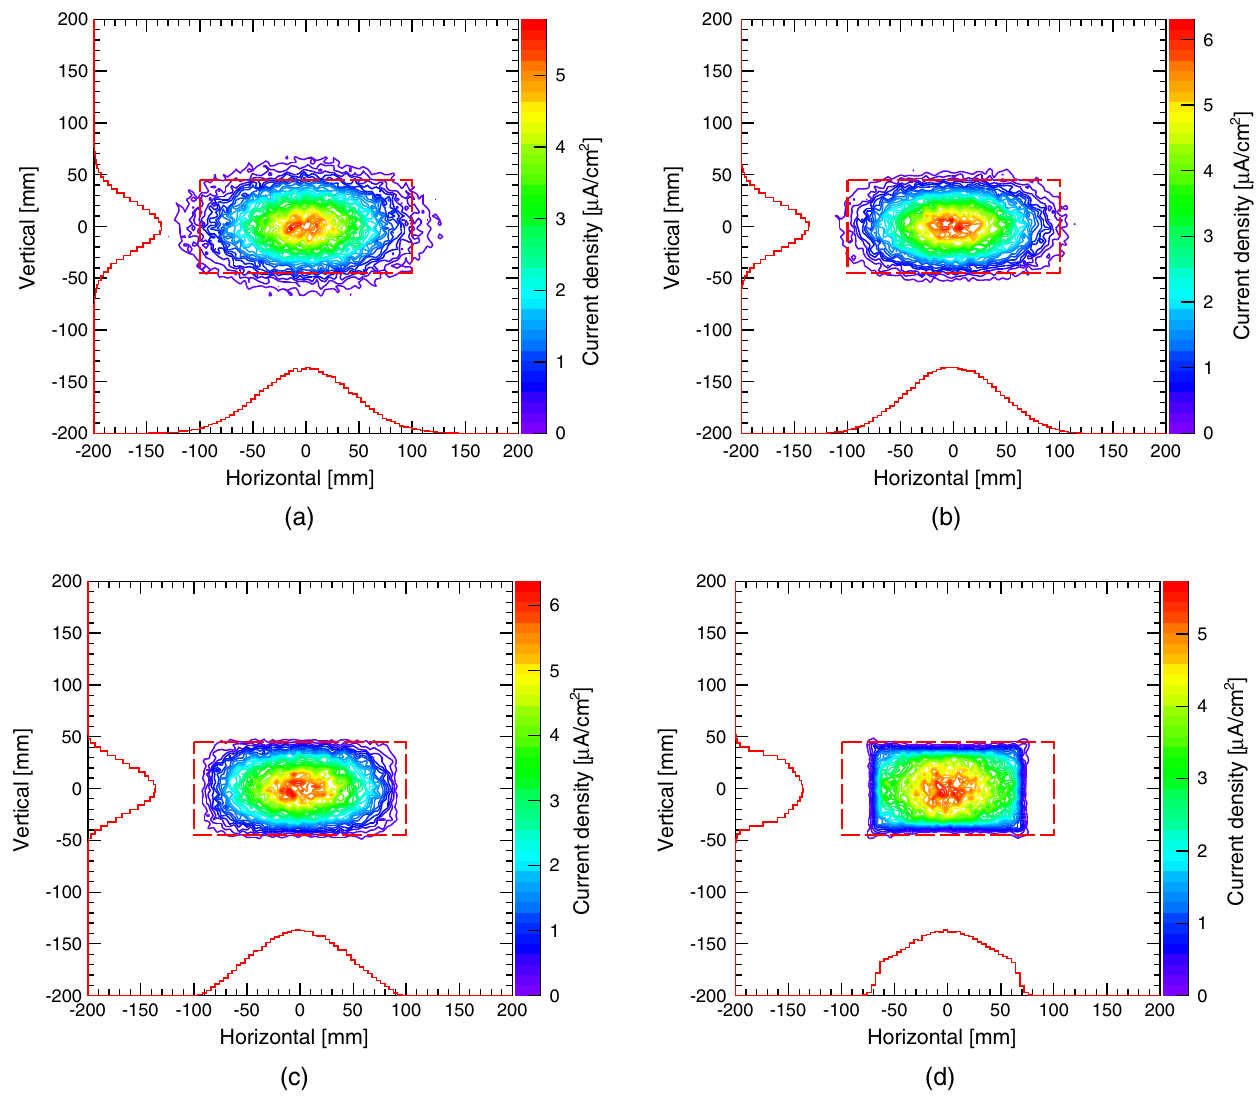
FIG. 15. Calculated beam profile at neutron production target for various currents supplied to octupole magnet without interaction with muon production target. Each panel shows both contour profile and projection profile on each plane. Panels (a) – (d) show the results for octupole currents of 0, 200, 400, and 698 A,